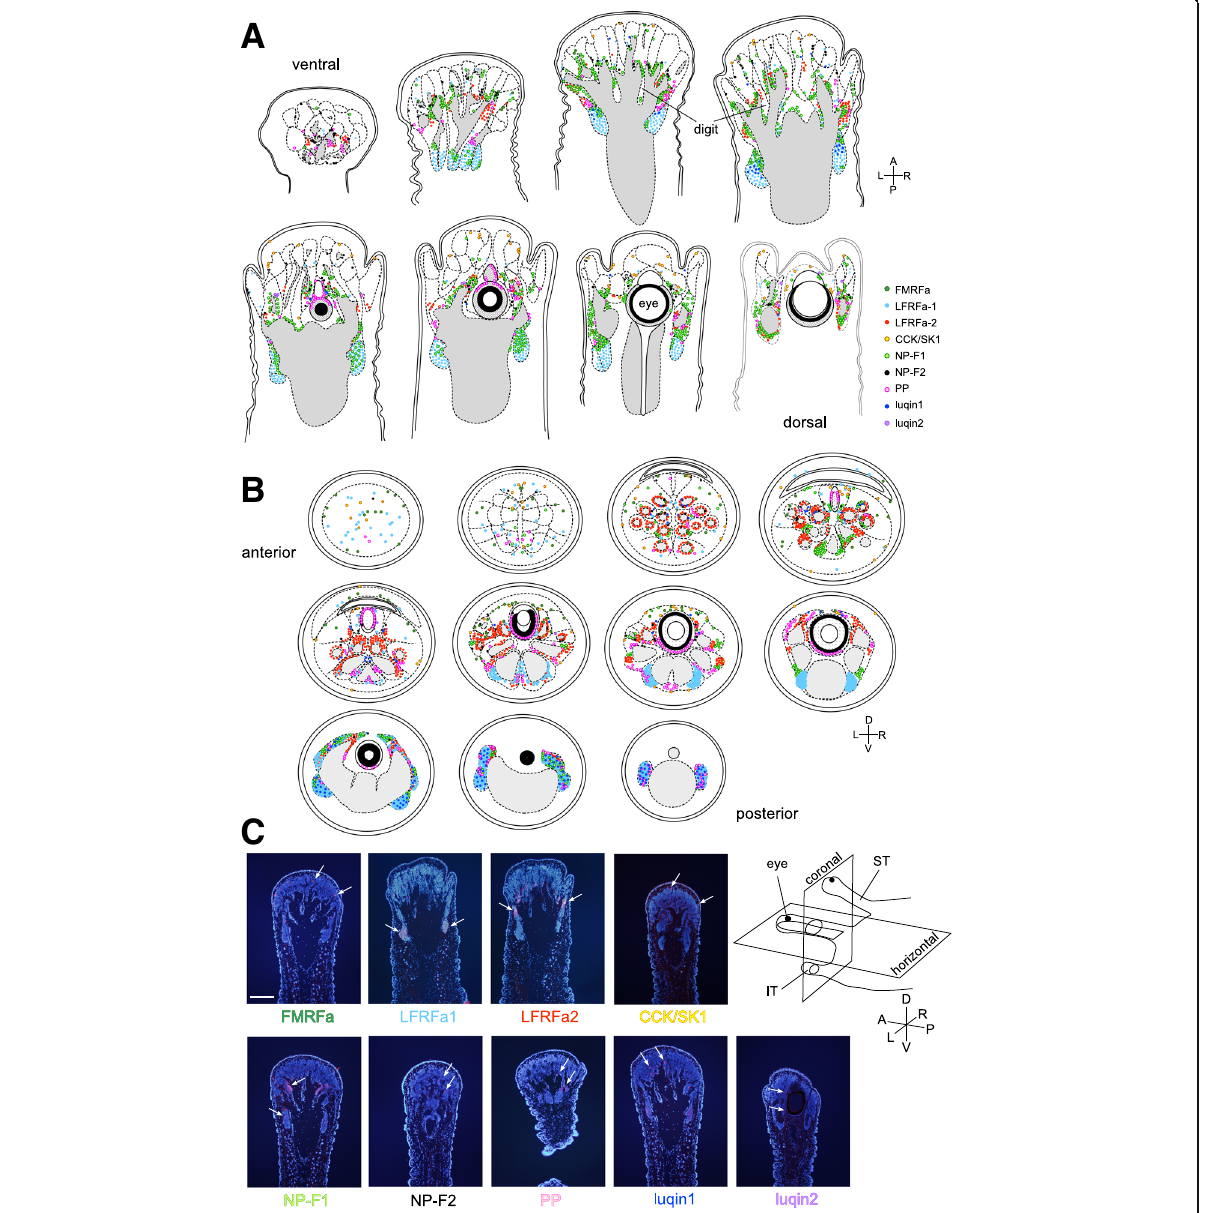
Fig. 4 The expression maps of 9 RFamide genes in the ST. Schemata showing the distribution of the neurons expressing RFamide genes in ( a ) horizontal and ( b ) coronal sections. c Examples of images of in situ hybridization in horizontal sections of the left ST. Positive signals are in red, and nuclei are in blue. White arrows indicate some of the positive signals. The cartoon on the right explains the direction of the sectioning plane. Scale bars: 200 μ m (applicable to all photographs). D, dorsal; V, ventral; A, anterior; P, posterior; R, right; L,